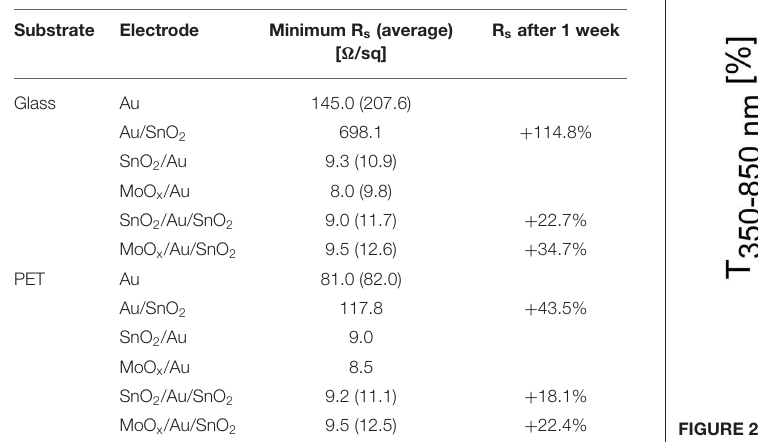
FIGURE 2 | Average transmittance (350–850nm) vs. sheet resistance of the dielectric/metal bilayers based on thermally evaporated MoO x (18nm) and Au films of different thicknesses (5, 7.5, and